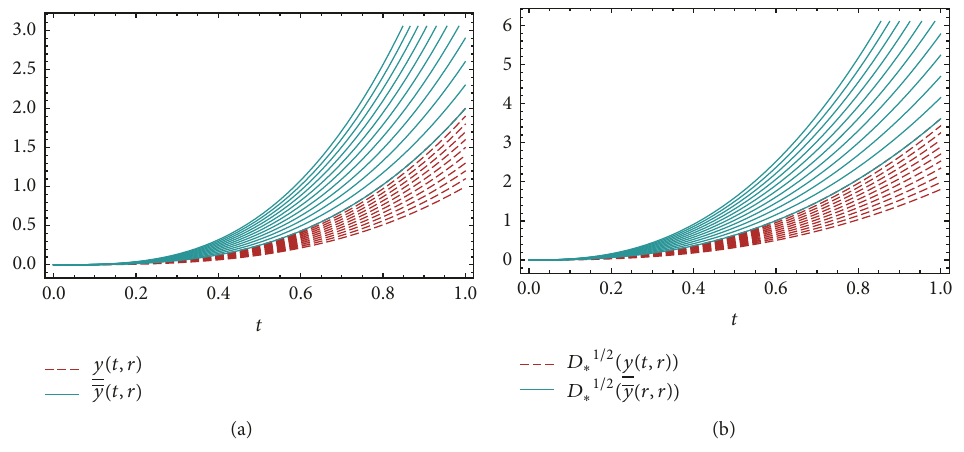
1/2 𝑦(𝑡) (b) of Example 1. ∗